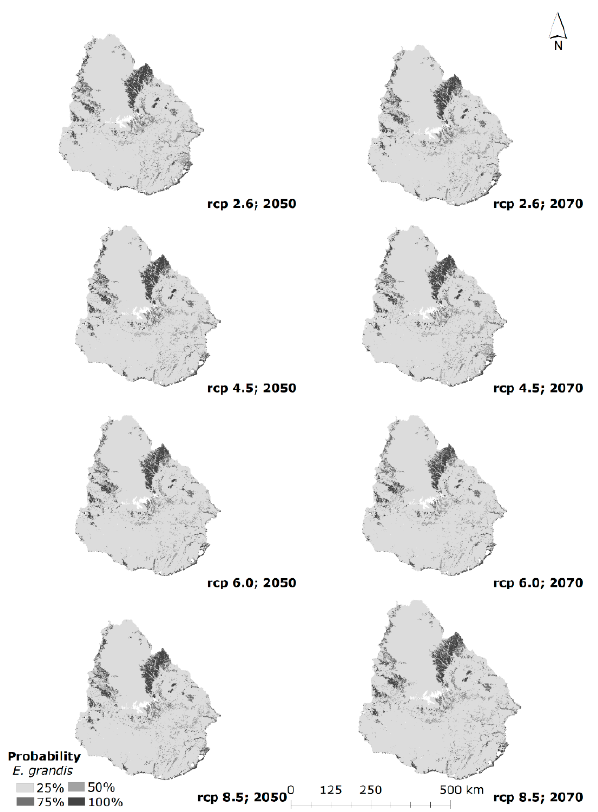
Figure 5. Future probability of occurrence of E. dunnii obtained with the ensemble model global circulation CCSM4, in the scenarios RCP 2.6, 4.5, 6.0, and 8.5, for the years 2050 and 2070.